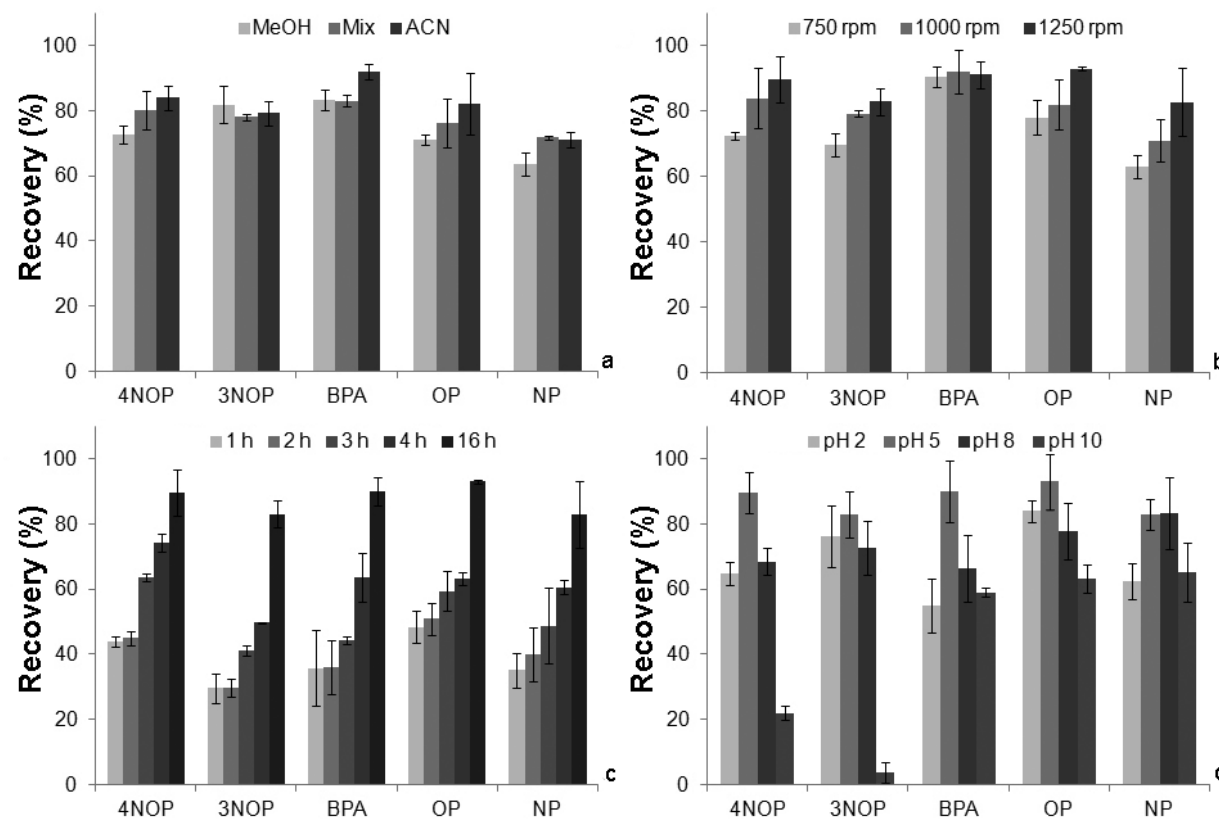
Figure 2. ( a ) Effect of desorption solvent, ( b ) agitation speed, ( c ) equilibrium time and ( d ) pH on the recovery yields.